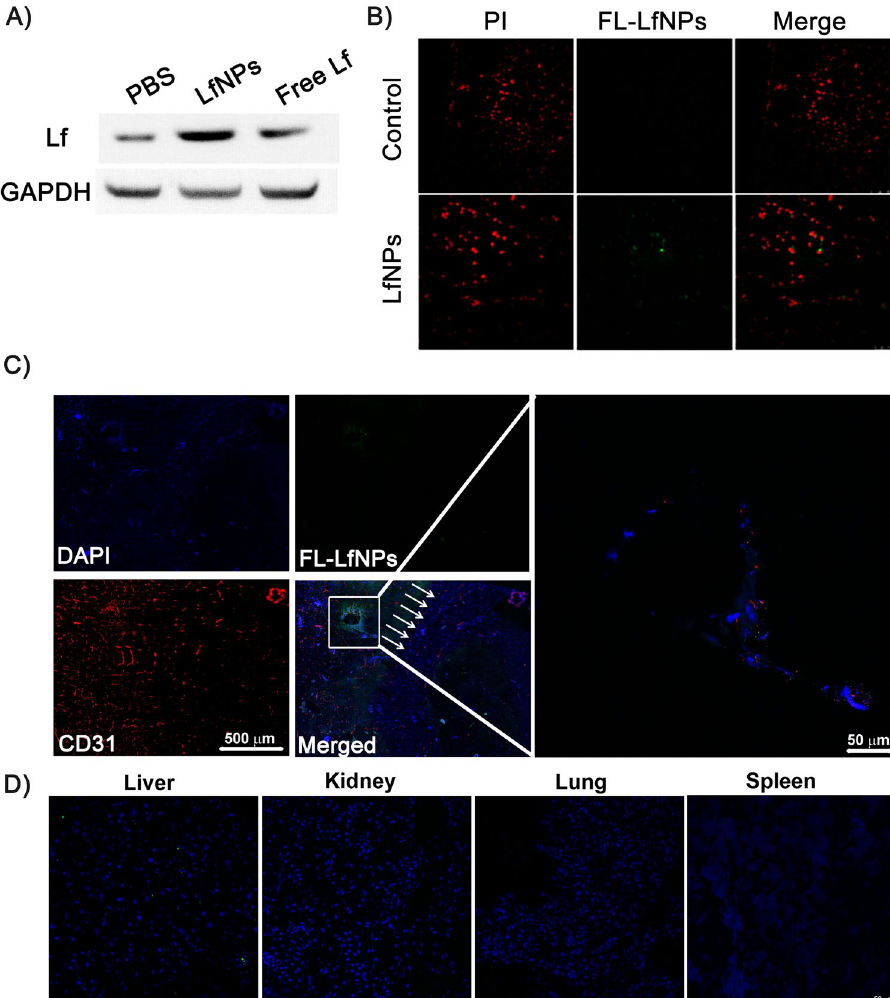
Figure 4. ( A ) Western blot for determining the Lf levels in brain of healthy mice injected with 100 µ l of 2 mg ml − 1 of free Lf and LfNPs (equivalent dose). (B) Immunohistochemistry images of brain tissues of control and LfNP-treated animals probed with anti-Lf antibody followed by Alexa Fluor-488 (green) tagged secondary antibody and counter-stained with PI (red). (C) Partial projection of a representative tile scan of the mouse brain showing strong fluorescence corresponding to FL-LfNPs (green) in the brain cortex (inset) above the hippocampus (white arrows). Area highlighted in white box is enlarged where fluorescence of FL-LfNPs (green) and brain micro-vessels (stained with anti-CD31 followed by secondary antibody tagged with Cy3 (red)) was visualized. (Scale bar = 500 µ m and 50 µ m (inset)). (D) Organ bio-distribution of FL-LfNPs. Representative confocal images depicts fluorescence signals present in the liver and absent in lung, kidney and